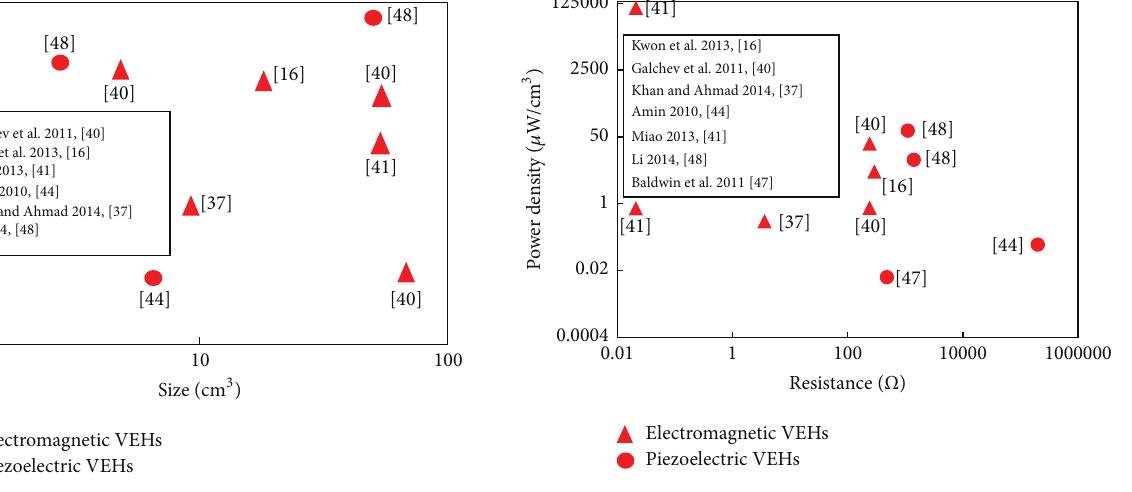
Figure 21: Power developed by the bridge vibration energy har- vesters as function of harvester’s size.